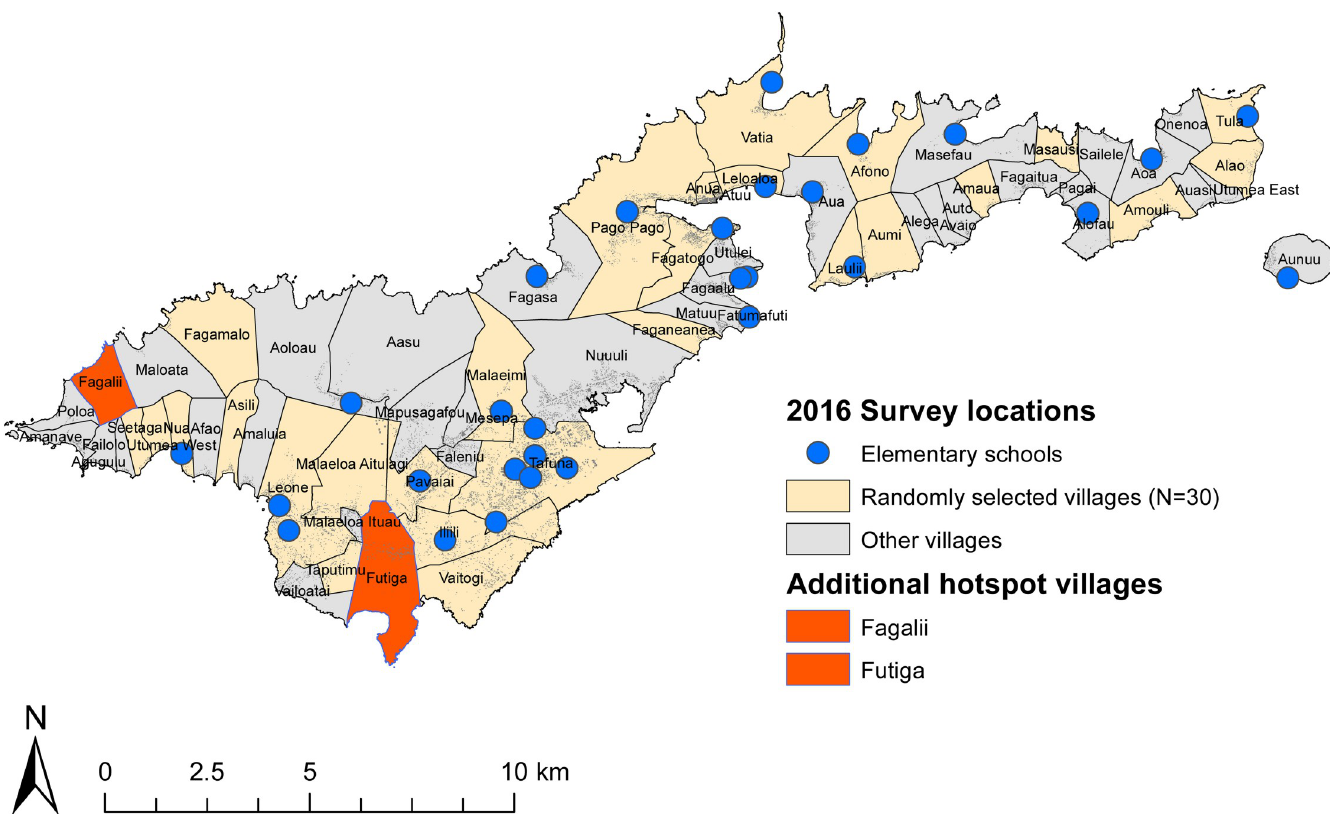
Fig 2. Survey locations in American Samoa 2016: elementary schools (blue circles), randomly selected villages (yellow), and additional hotspot villages (orange).